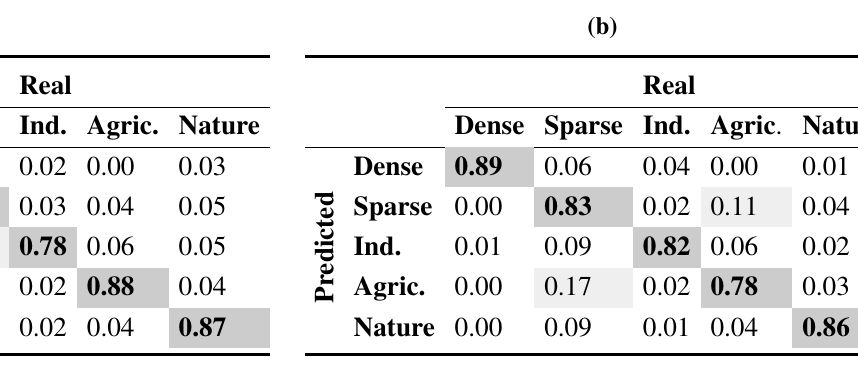
Table 2. Confusion matrix of München and Brussels with the five classes (dense residential, sparse residential, industrial, agricultural, nature). City-specific model with 50 predictors and all of the observations. ( a ) Best city: München; ( b ) Worst city: